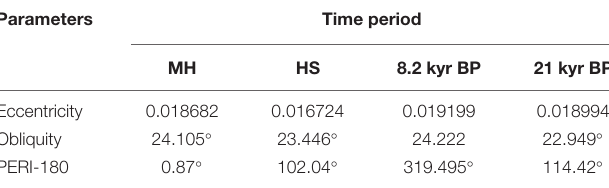
TABLE 2 | Orbital parameters of the different climatic periods.